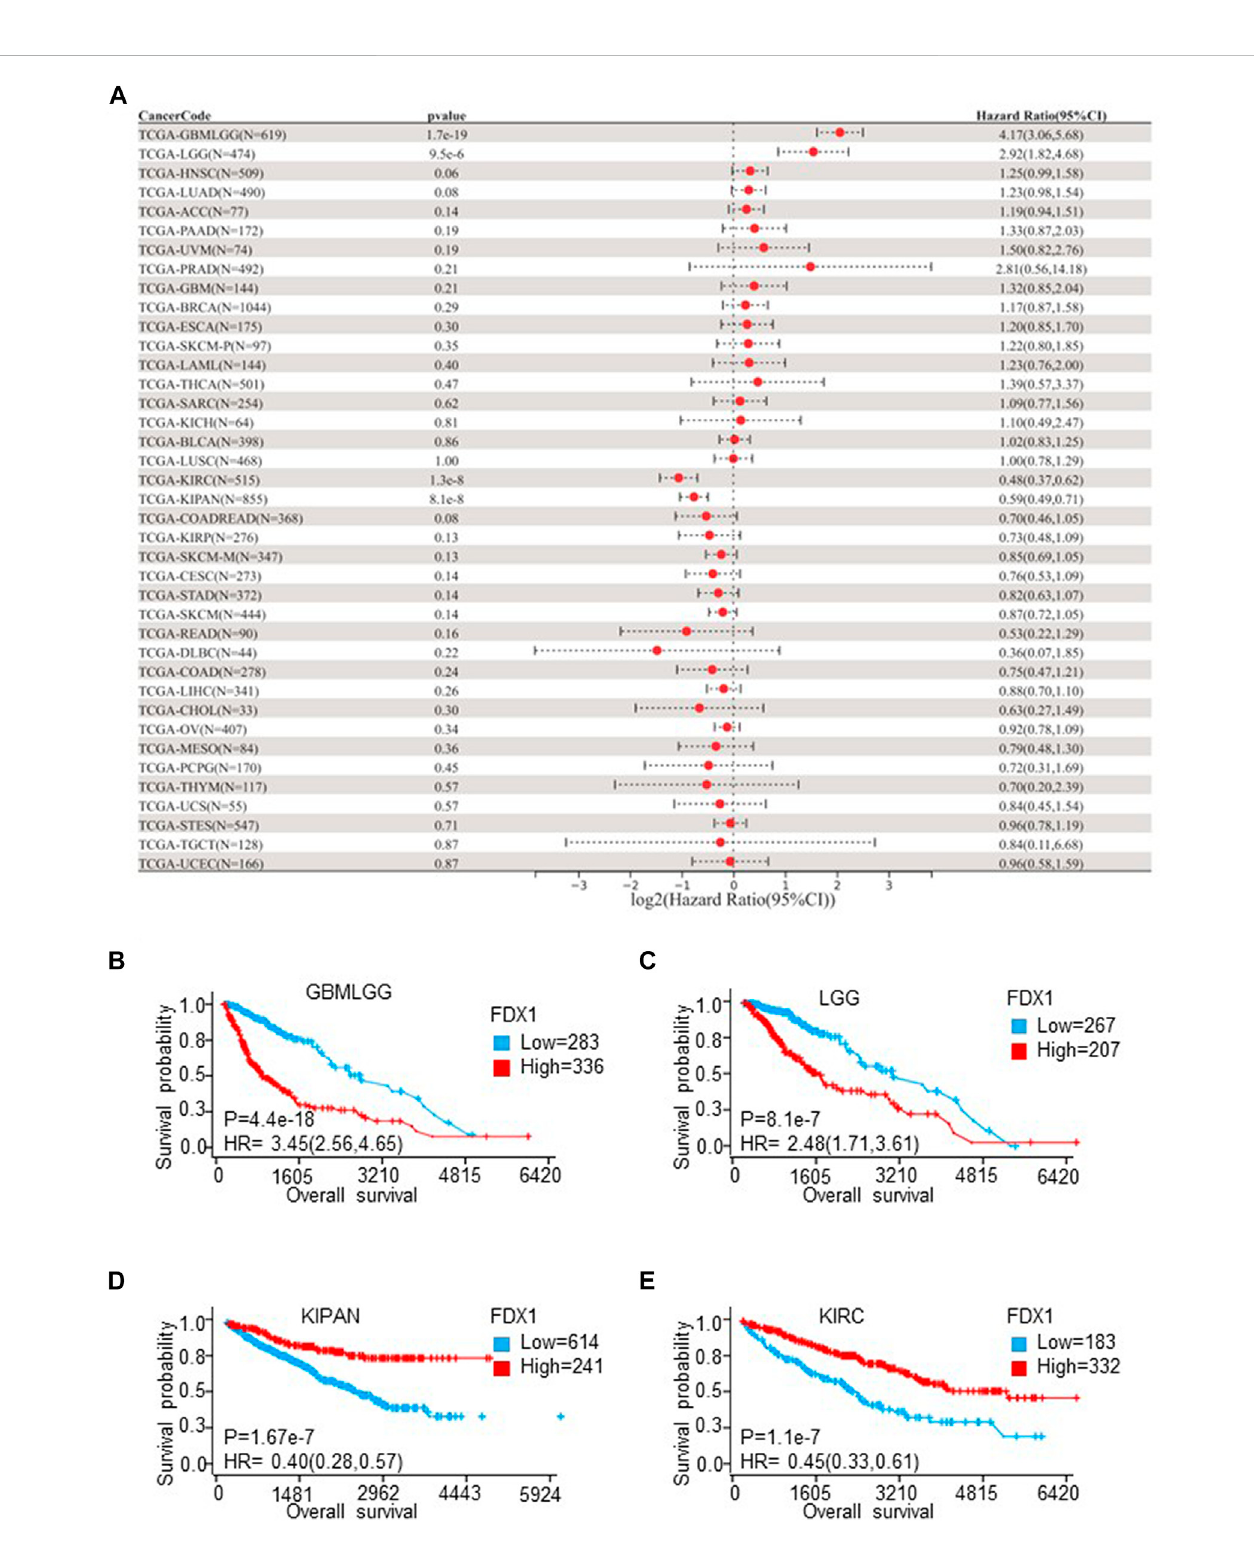
FIGURE 3 The overall survival (OS) analysis of FDX1 in different cancer types according to TCGA Pan-Cancer database. (A) The relationship between FDX1 expression and hazard ratio (HR) was shown by the forest plot. (B – E) Kaplan-Meier plot shows the relationship between FDX1 expression and OS in LGGGBM, LGG, KIPAN, and KIRC. (LGGGBM: glioma, GBM: brain lower-grade glioma, KIPAN: pan-kidney cohort, KIRC: renal clear cell carcinoma. p < 0.05 was considered signi fi